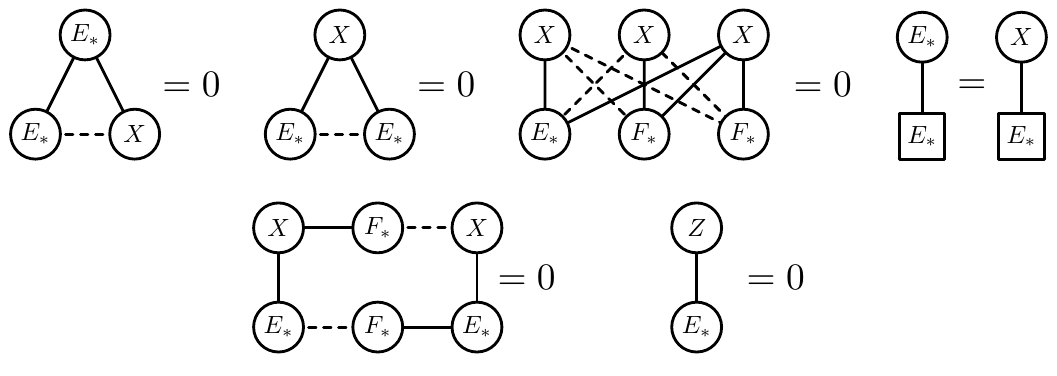
Figure 11: The decorated constraints forcing the structure of the composite tiles E ∗ × X for X ∈ { A ,..., A M , B G 1